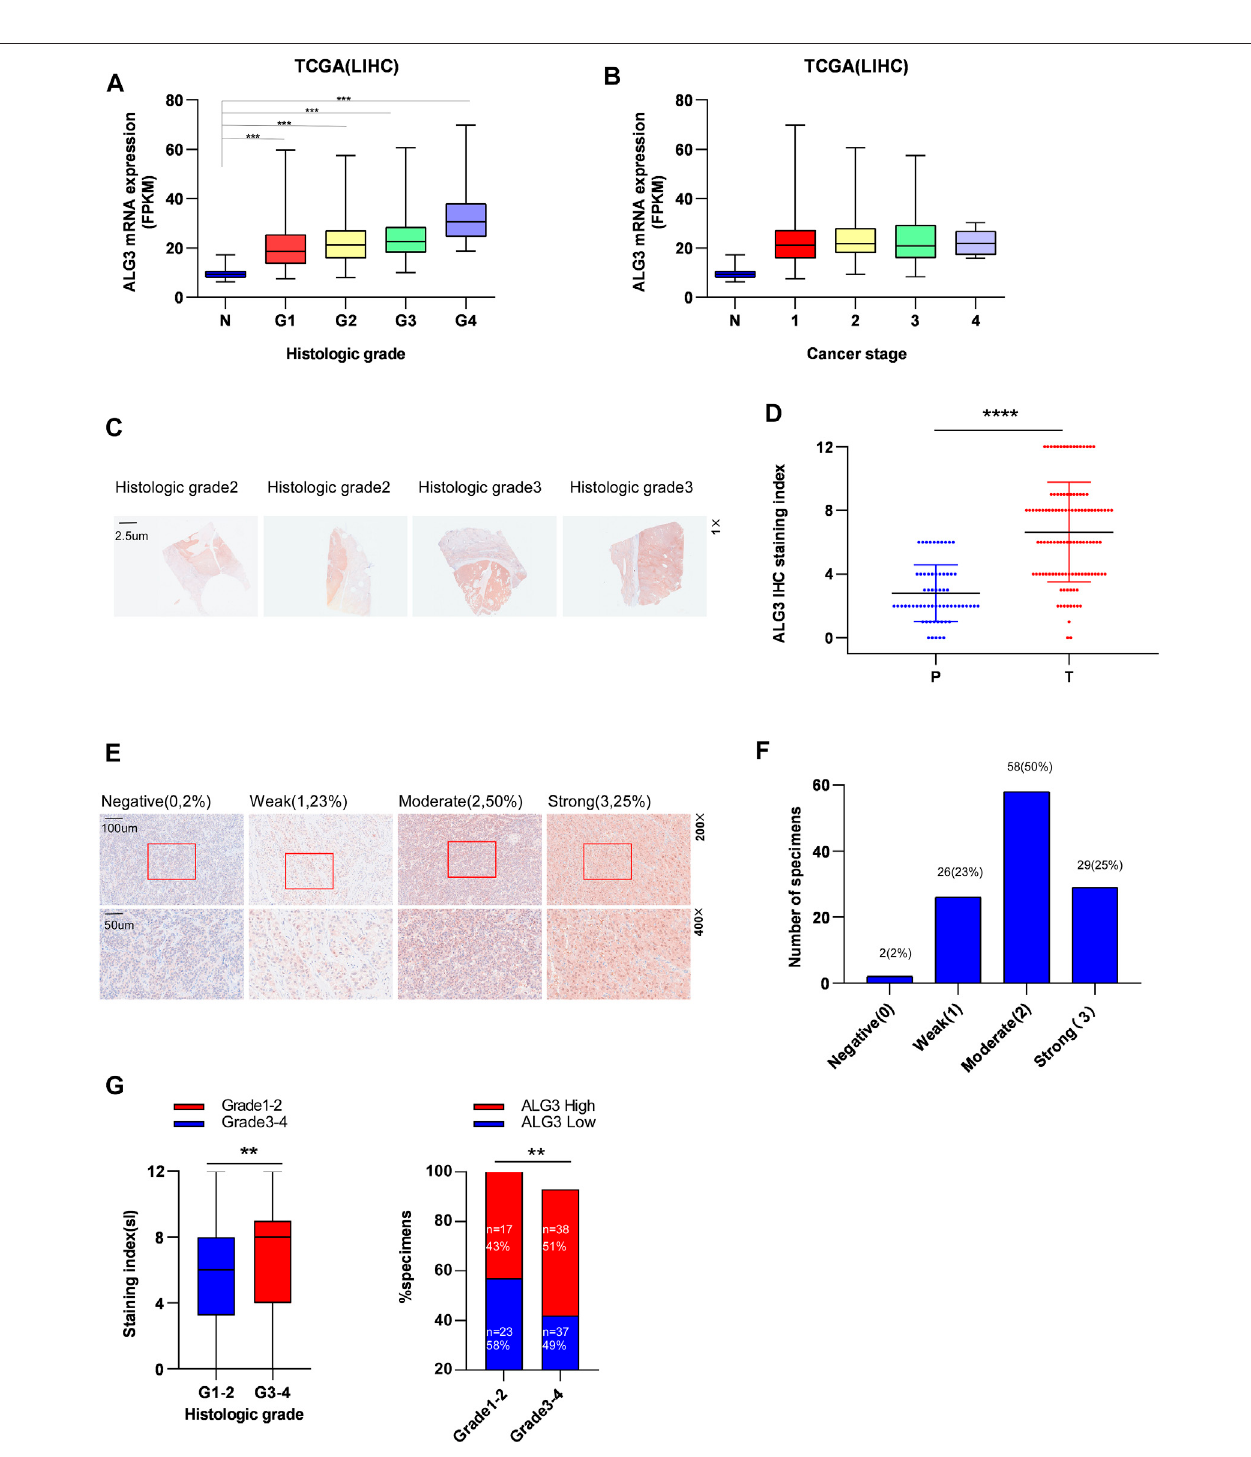
FIGURE 3 | Relationship between ALG3 and clinicopathologic features of HCC patients. The expression of ALG3 is ordered by histologic grade (A) and cancer stage (B) in TCGA. (C) Representative images of ALG3 staining in paired HCC tissues. (D) Detailed IHC staining index. (E) IHC analysis of ALG3 protein expression in HCC tissues of different representative images. The bottom shows a double magni fi cation of part of the aforementioned image. (F) Number of cases with different staining intensities. (G) ALG3 expression levels in different histologic grade specimens. (** p < 0.01, *** p < 0.001, and **** p < 0.0001).